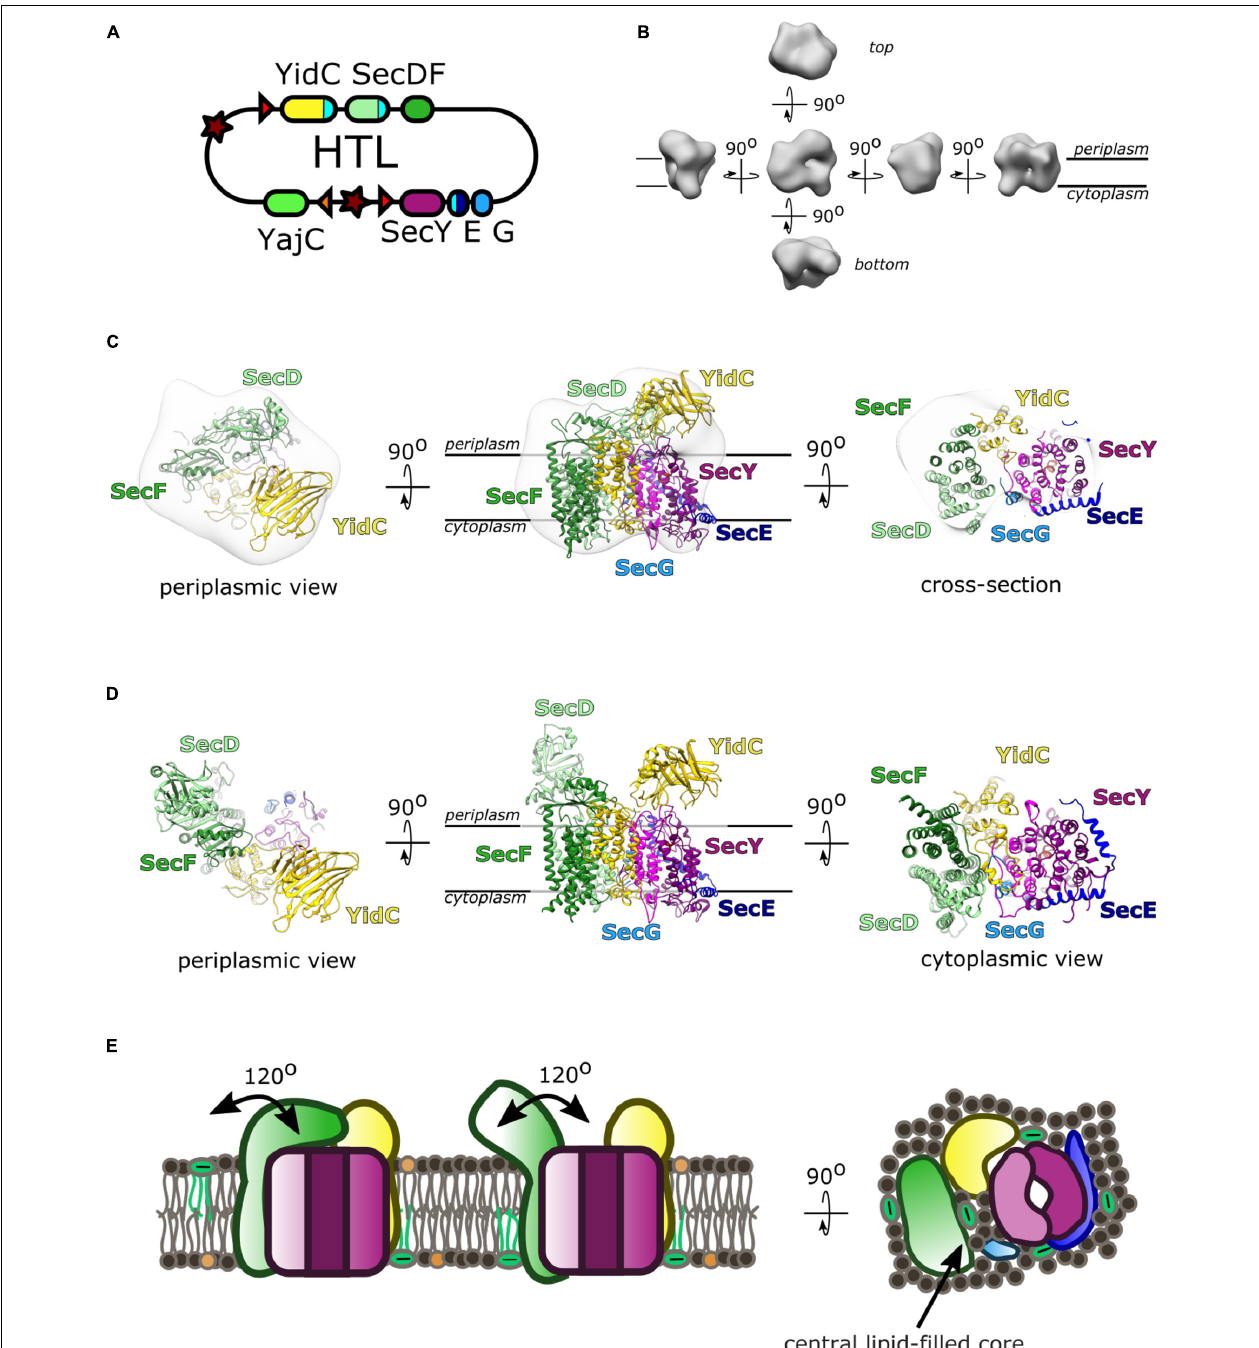
FIGURE 3 | The Holo-translocon of E. coli . (A) Plasmid system for expression of HTL (Bieniossek et al., 2009). (B) 14 Å resolution electron density of HTL in amphipols (EMD:3506; Botte et al., 2016). (C) Computational fitting of individual components of HTL to this density (PDB:5MG3 Botte et al., 2016). SecDF (green; SecD P1 domain, light green), YidC (yellow), SecYEG (magenta, dark blue, light blue). (D) A suggested alternate conformation of this complex where SecDF periplasmic domain is rotated into the I -form (Martin et al., 2019). (E) Schematic of HTL depicting SecDF rotation and the central lipid